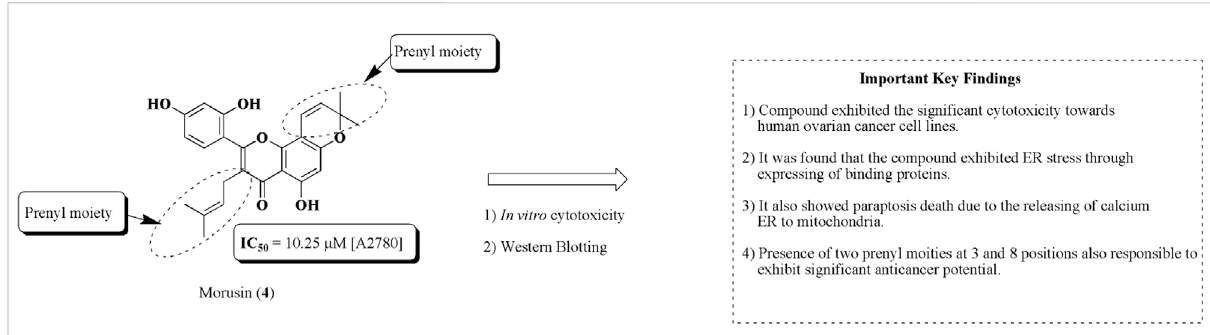
FIGURE 9 Structure of morusin along with important key fi ndings. Anti-ovarian cancer potential of morusin was assessed by in vitro cytotoxicity and Western blotting. Prenyl moieties seem to be structurally responsible for this activity.